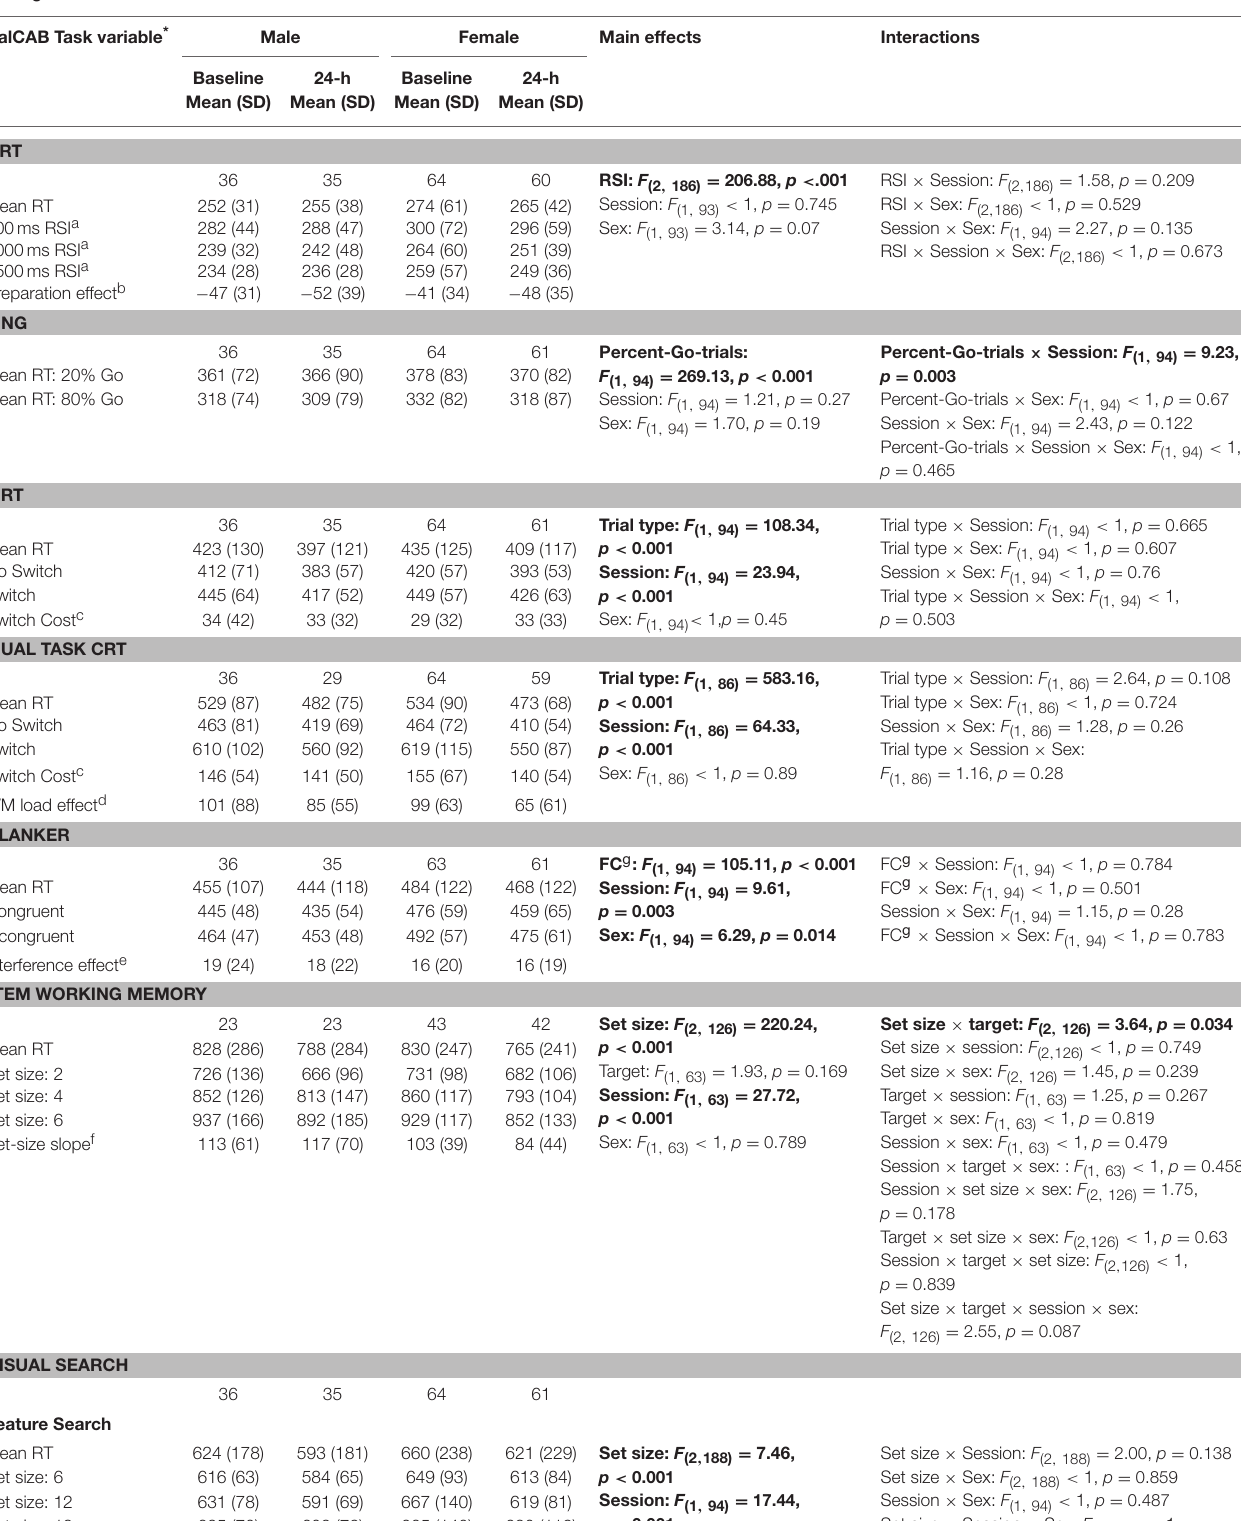
TABLE 3 | Reaction times (RT; in ms) for relevant variables on the DalCAB tasks for groups of male and female participants at the baseline and 24-h testing sessions. DalCAB Task variable * Male Female Main effects